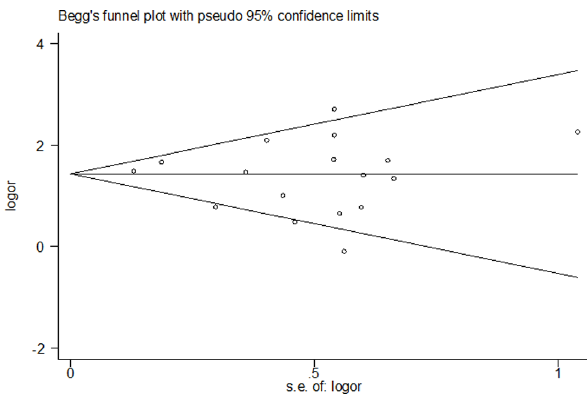
Figure 5. Begger’s test indicating no obvious publication bias of 17 studies included in this